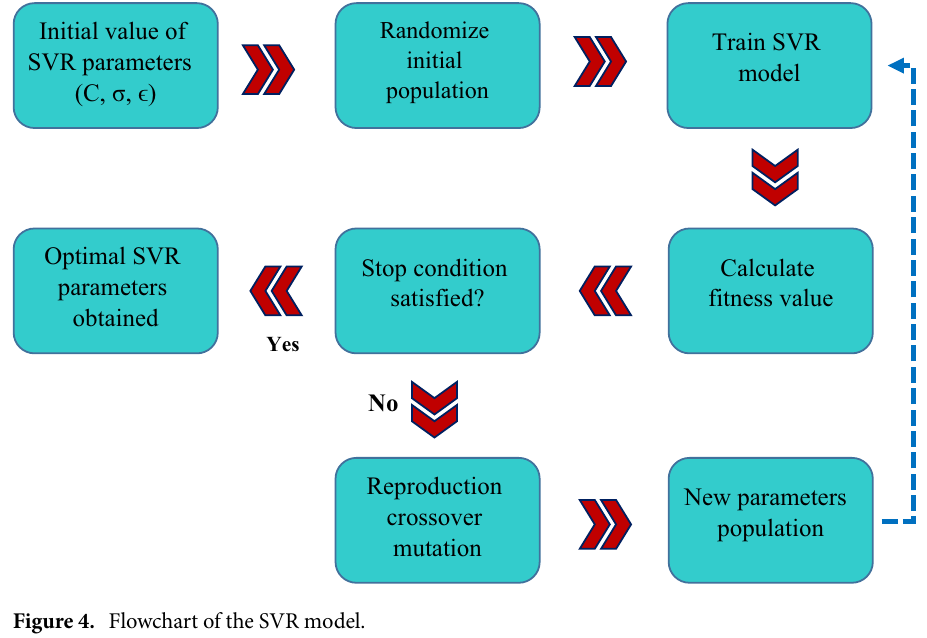
Figure 4. Flowchart of the SVR